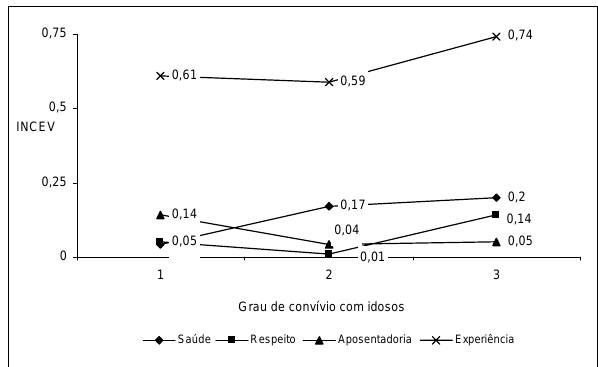
Figura 1 . Diferenças na estrutura da representação social conforme o grau de convívio com